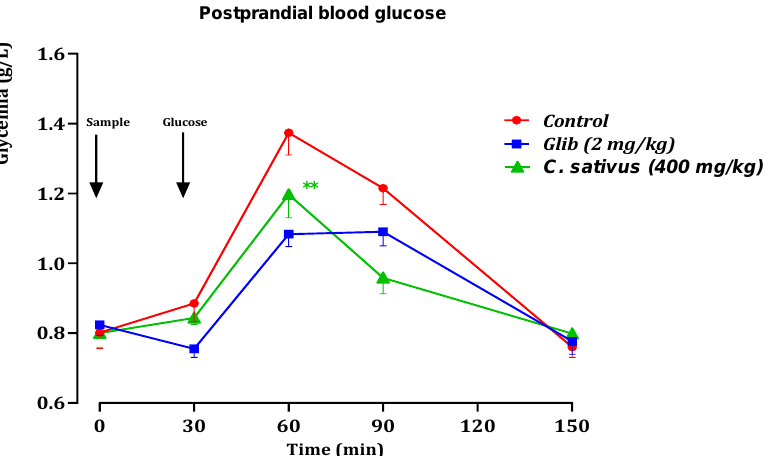
Figure 10. Variation in postprandial blood glucose in normal rats after administration of test products